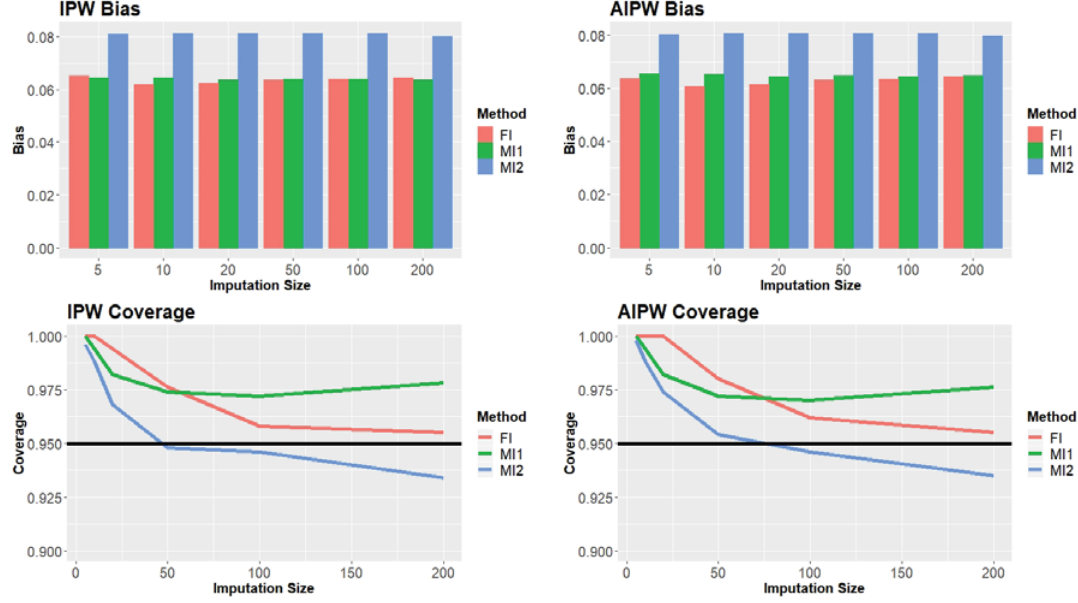
Figure A1: Comparing sensitivity to size of M on bias and coverage among FI and MI implementations when estimating treat- ment effects via IPW